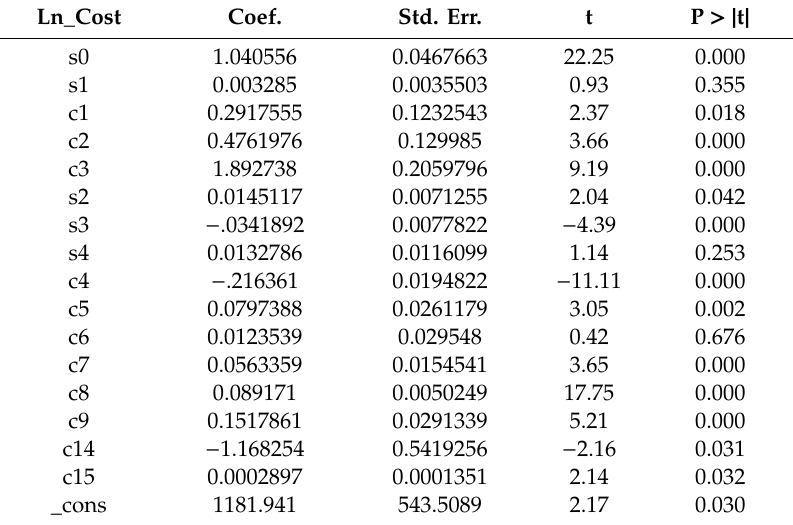
Table 3. Lerner Cost Function Estimate Fixed E ff ect with 1081 Observations. Dependent